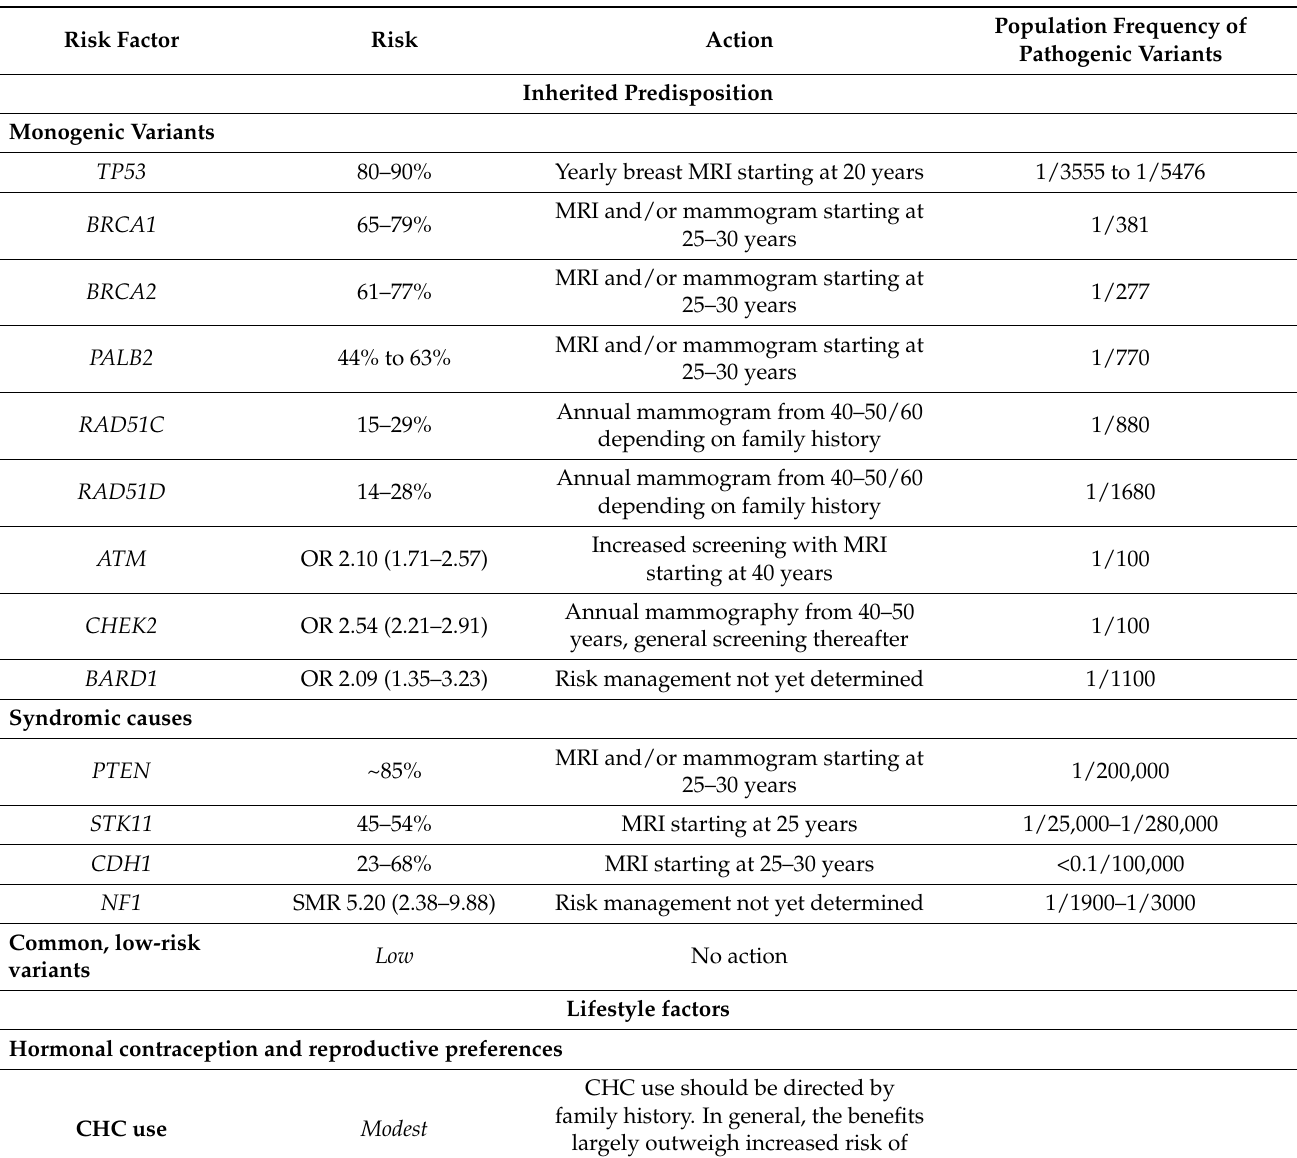
Table 2. Summary of risk factors for breast